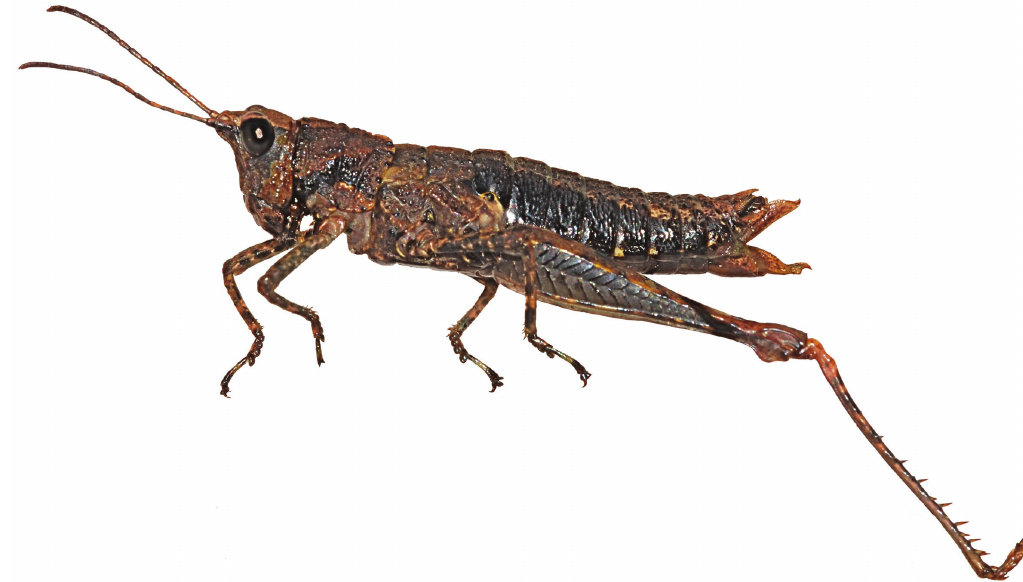
Fig. 2. G. terrea, female from Mpanga forest, Uganda (2°97'78"N, 32°64'22"E).